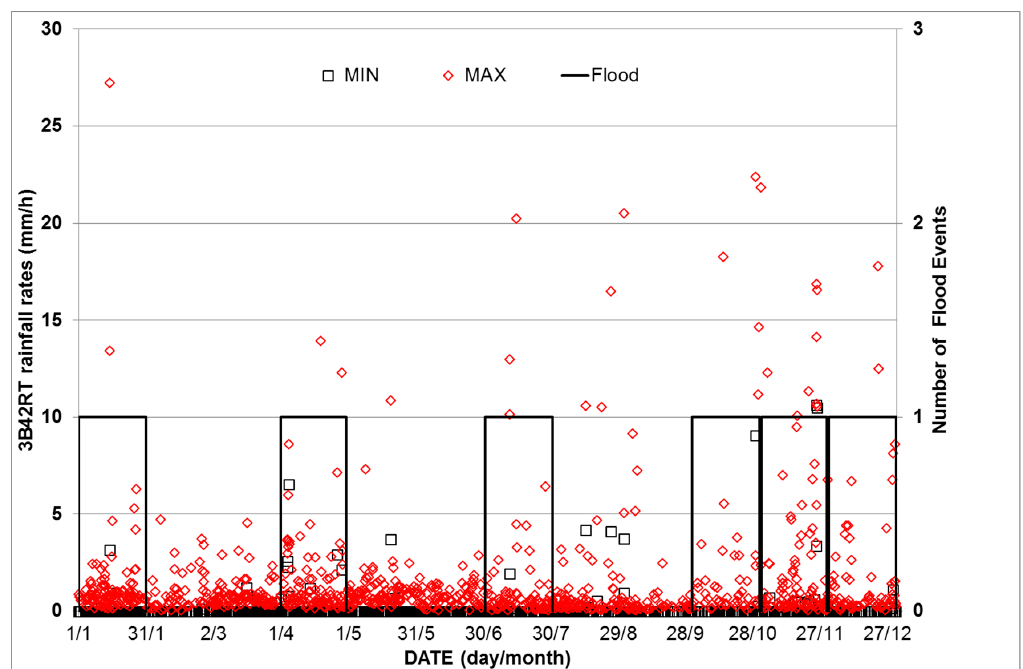
Figure 6. Temporal distribution of major flood events over Jeddah throughout the year and minima ( black squares ) and maxima ( red diamonds ) rainfall rates obtained from 3B42RT data for Jeddah between 2000 and 2014.